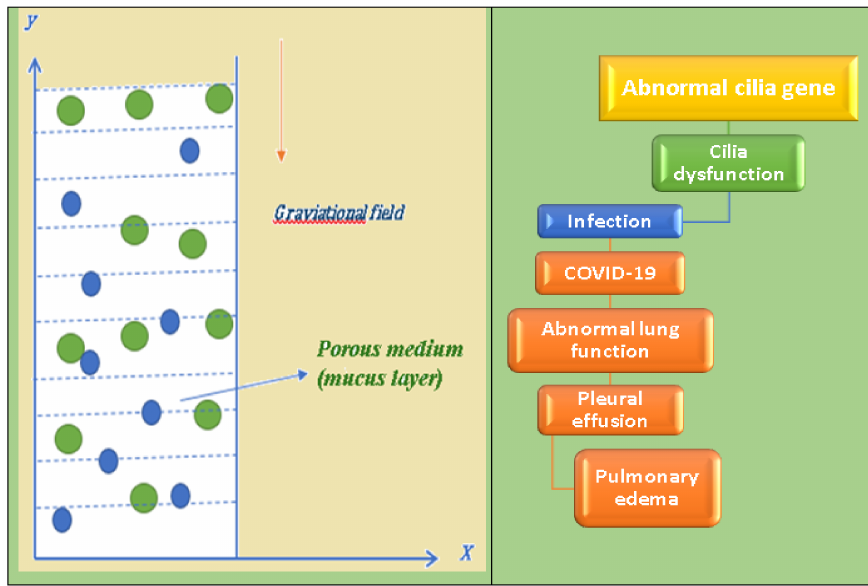
Figure 1. Multiple lung disorders arrangement and flow